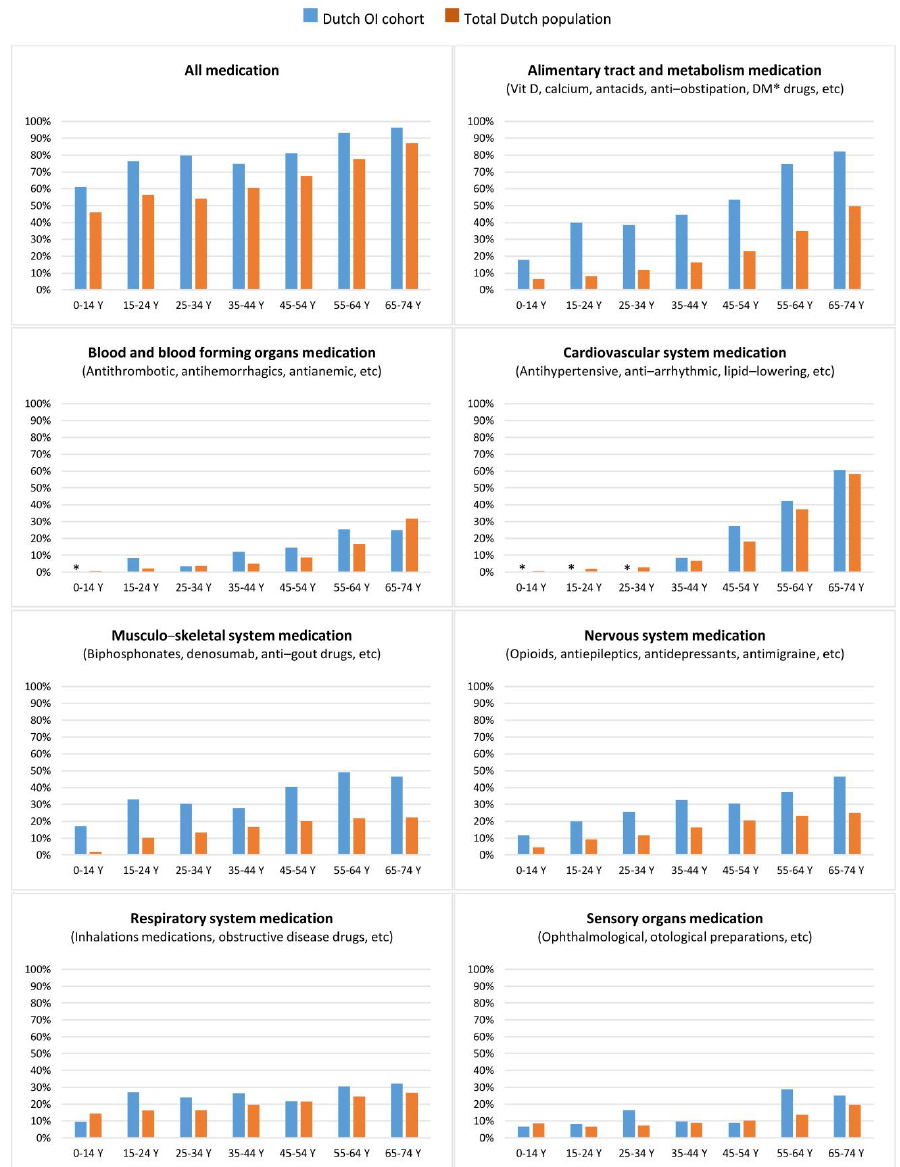
Figure 2. Proportion of the Dutch OI cohort and total Dutch population using medication belonging to specific ATC categories.OI, Osteogenesis Imperfecta; Y, year. * Due to low patient number exact percentage is not shown (* = <4%). Further information on ATC categories: “ https://www.whocc.no/atc_ddd_index/ ” (last accessed on 14 November 2022) .